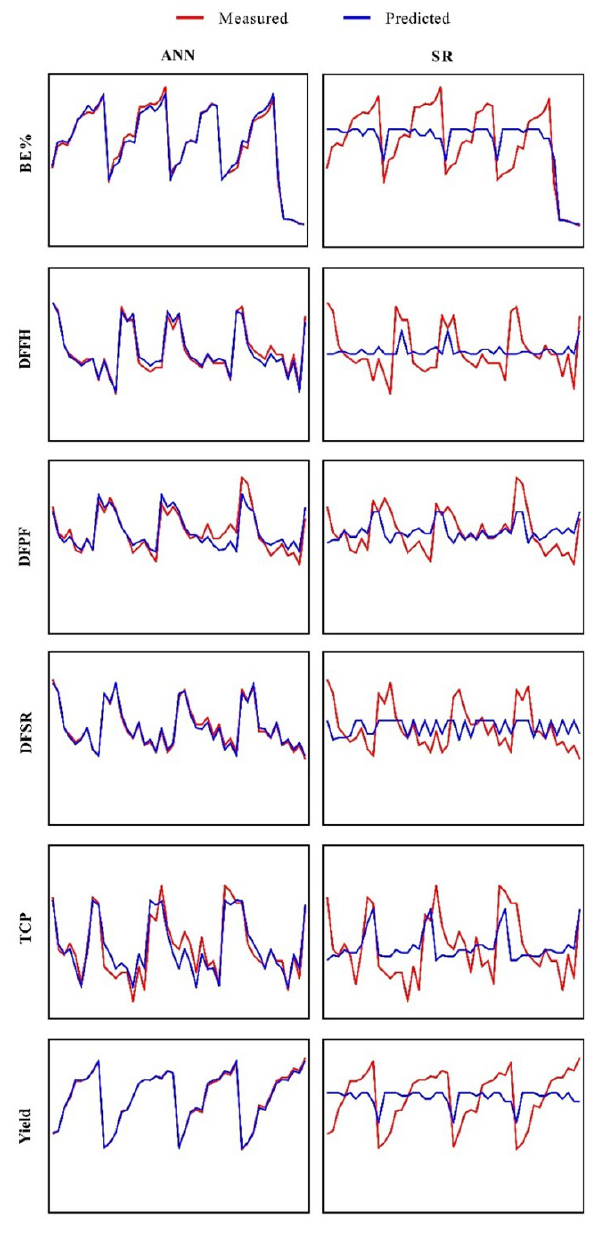
Fig 4. Prediction of yield, biological efficiency (BE), spawn run period (SRP), days for pinhead formation (DPHF), days for the first harvest (DFFH), and total cultivation period (TCP) in Auricularia cornea cultivation on different substrates obtained from different ratios of beech and hornbeam sawdust supplemented with wheat and rice brans, based on multilayer perceptron-genetic algorithm (MLP-GA) and stepwise regression (SR) models in training